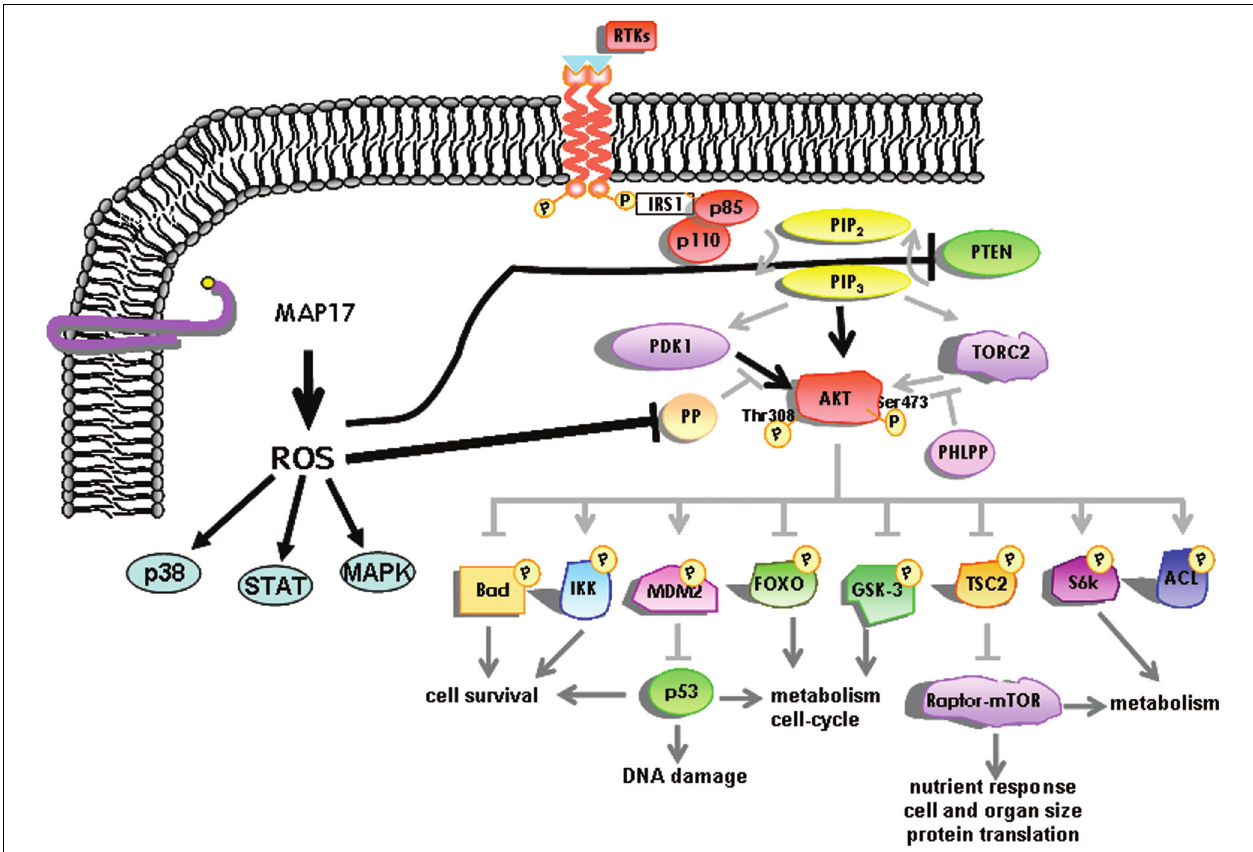
FIGURE 3 | Schematic representation of the intracellular pathways activated by MAP17 through ROS. The AKT pathway is represented in more detail.